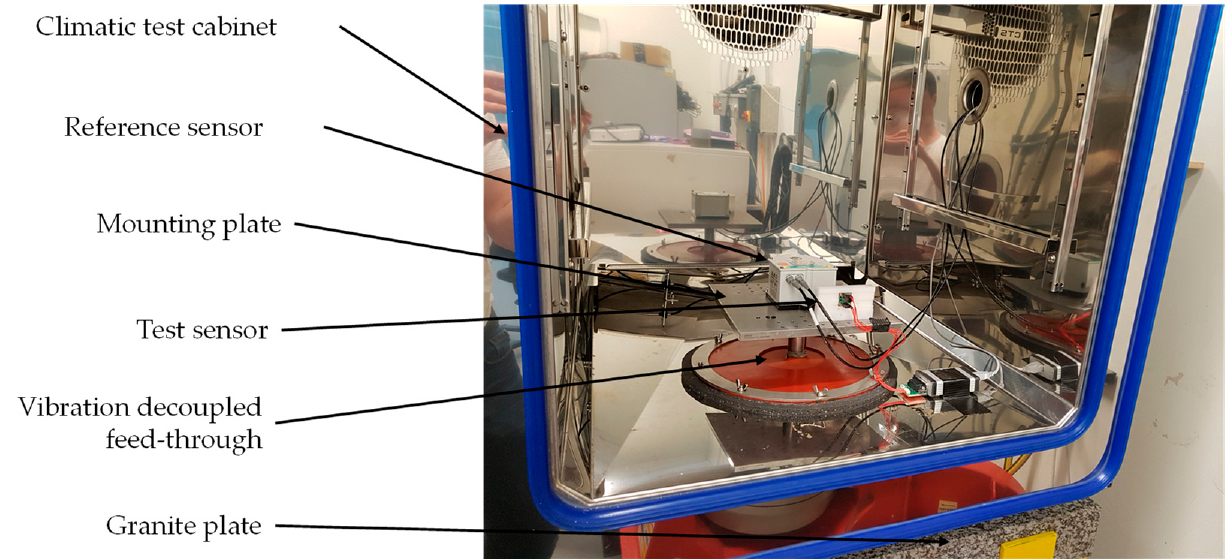
Figure 5. Climatic test chamber with mounting device for the sensors.